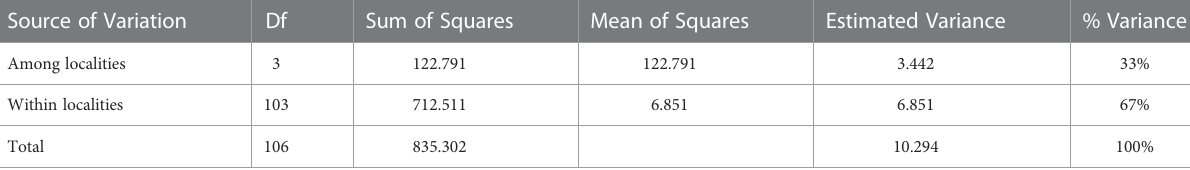
TABLE 3 Analysis of Molecular Variance based on 48 AFLP loci among and within two Saxon localities of Luronium natans ( Niederspree : DE_Ni and Großenhain : DE_Gr). Source of Variation Df Sum of Squares Mean of Squares